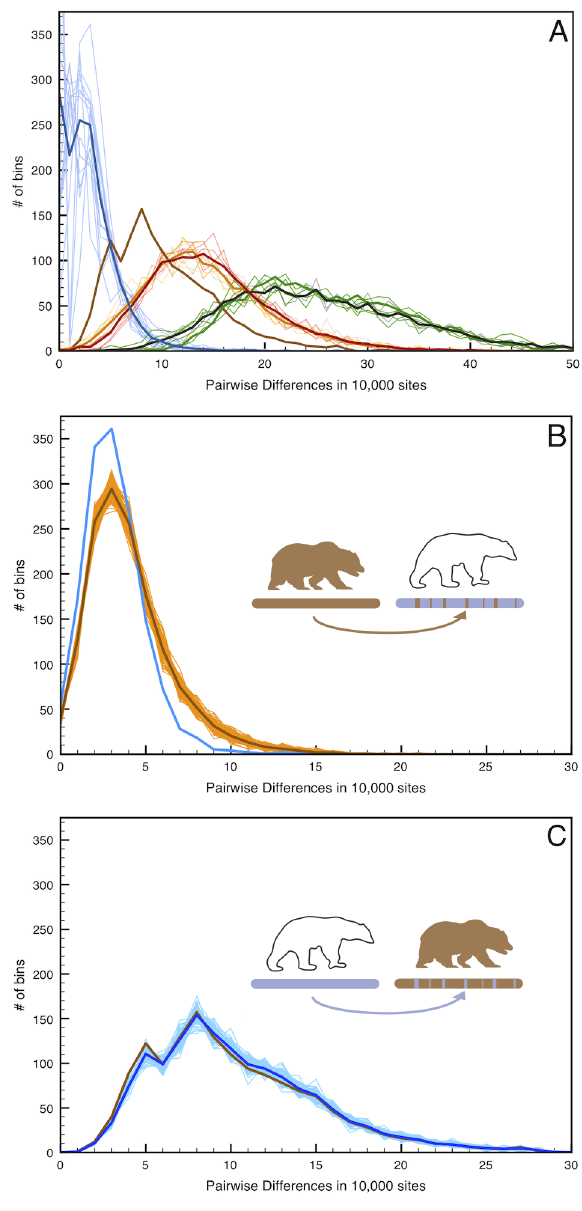
Figure 4. Simulated admixture reveals the direction of gene flow on the X chromosome. (A) Pairwise distance as in Figure 2 but limited to the 12 scaffolds identified as X-chromosome. (B) 100 replicate simulations in which 6.5% of the female West Hudson Bay polar bear X- chromosome is replaced with that of the mainland Alaska brown bear in randomly inserted 20 kb fragments, simulating admixture from the brown bear genome into polar bear , 50kya. Pairwise differences are calculated between the simulated genome (light brown lines; mean highlighted in dark brown) and the plot comparing the two female polar bears (blue line), to maximize the number of informative sites in the test. The addition of brown bear DNA to the polar bear genome markedly increases the number of high-diversity bins ( . 10 differences/ 10 kb), indicating that any introgression of brown bear DNA into polar bears should be easily detectable. (C). As in (B), but with 6.5% of the mainland Alaska brown bear X-chromosome is replaced with that of the female West Hudson Bay polar bear. In this instance, we find no difference between the simulated (blue lines) and real (brown line) data.